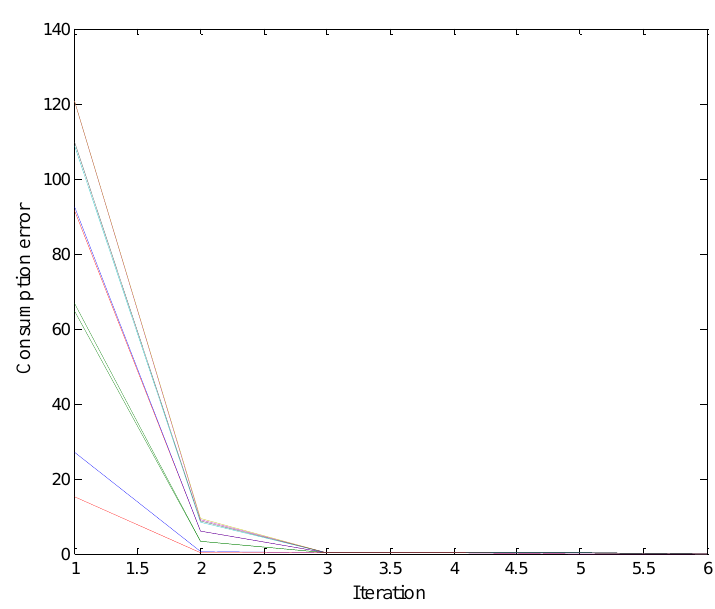
Figure 10. The convergence of the prosumers’ electricity consumption based on a non-cooperative game. Energies 2016 , 9 , 536 The results show that the iterative process of each prosumer can be completed within 5 generations with high efficiency. Before and after the DR, the comparisons of the internal prices and prosumers’ utilities in time periods 7–18 are shown in Figures 11 and 12, respectively.